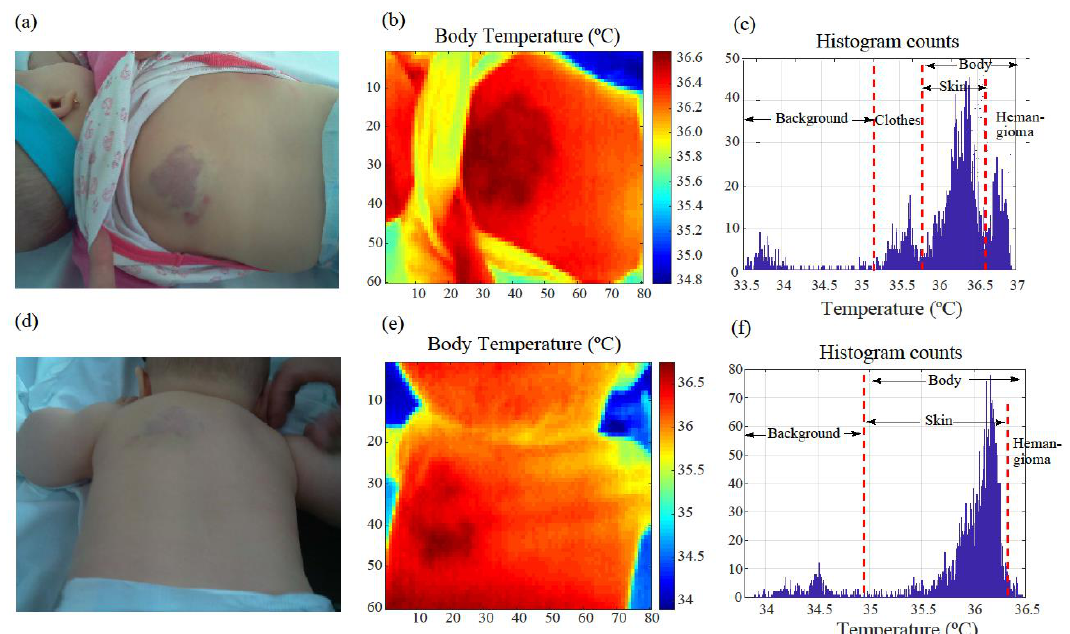
Figure 5. ( a – f ) Study of the temperature of an infantile hemangioma on the patient’s back, before and after a two-month course of treatment with oral propranolol. The patient was 3 days old at the first consultation. ( a , d ) Images of the hemangioma obtained with a standard digital camera. ( b , e ) Thermographic images of the same hemangioma, displaying the absolute temperature values. A temperature increment in the hemangioma compared with its surroundings is observed, ( c , f ) Histograms of the thermal images. The histogram modes correspond to the average temperature values in the different scene regions, i.e., image background, hair, skin, and hemangioma.